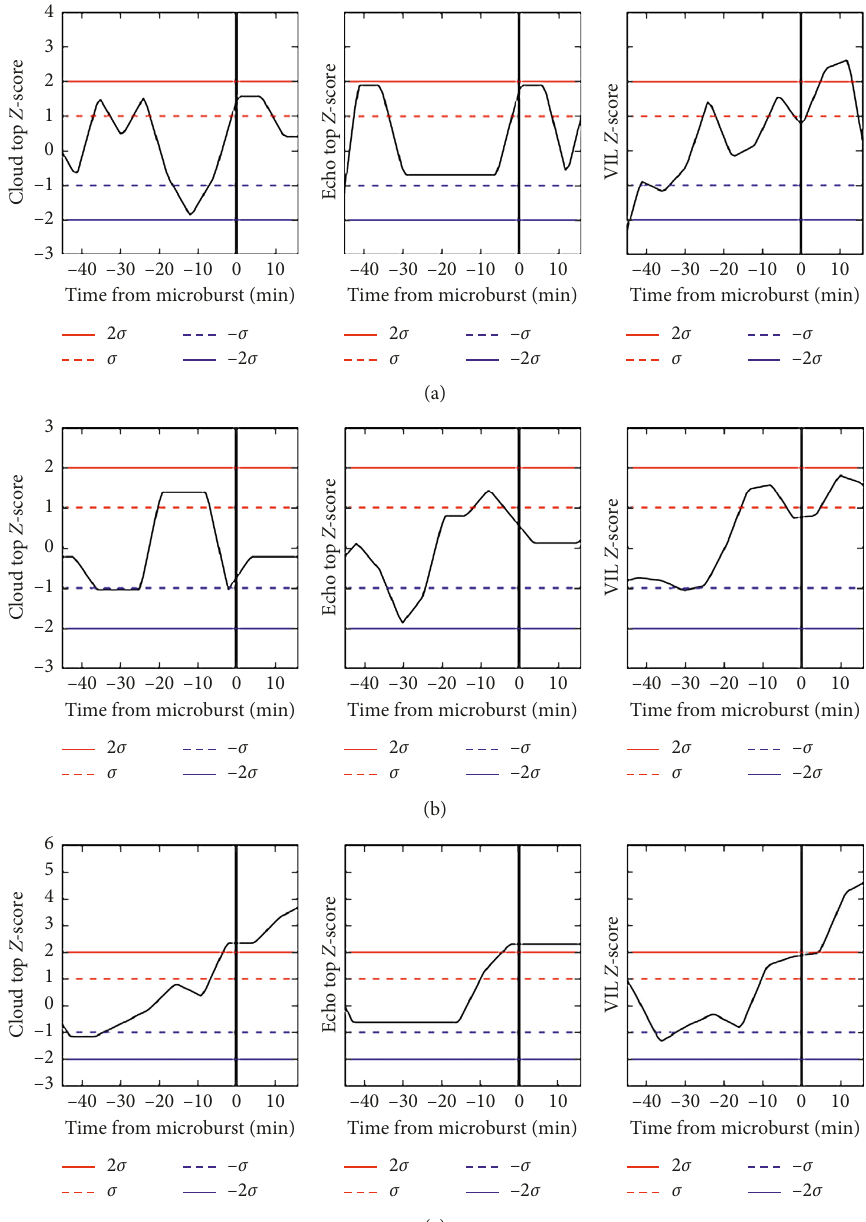
Figure 11: As in Figure 9, except for the last three cases. (a) 20150803 microburst. (b) 20160616 microburst. (c) 20160701